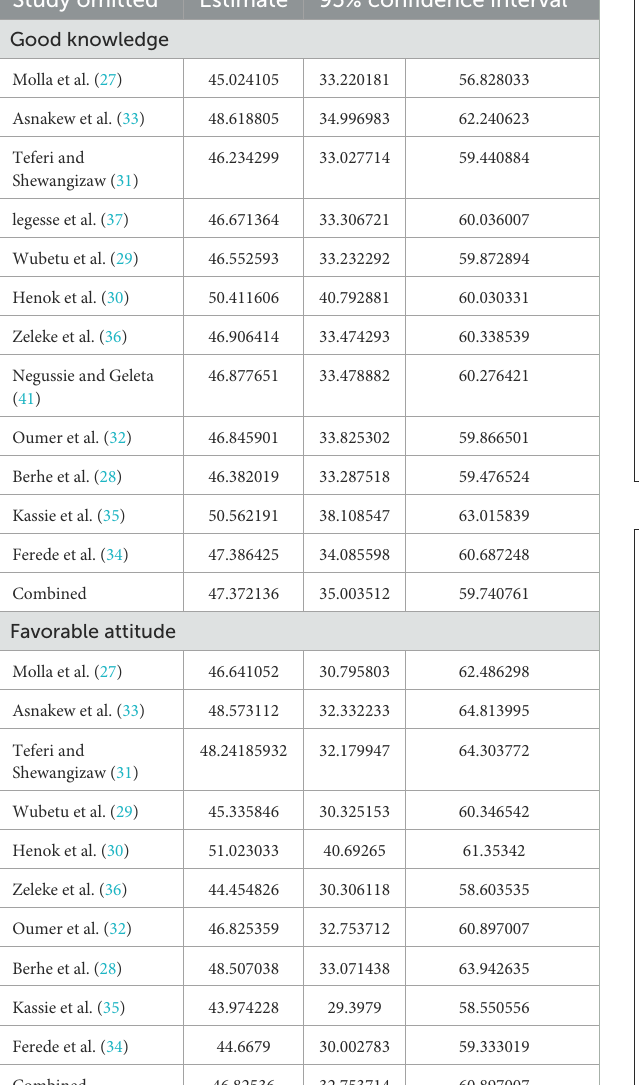
FIGURE8 Funnel plots of publication bias for favorable level attitudes toward